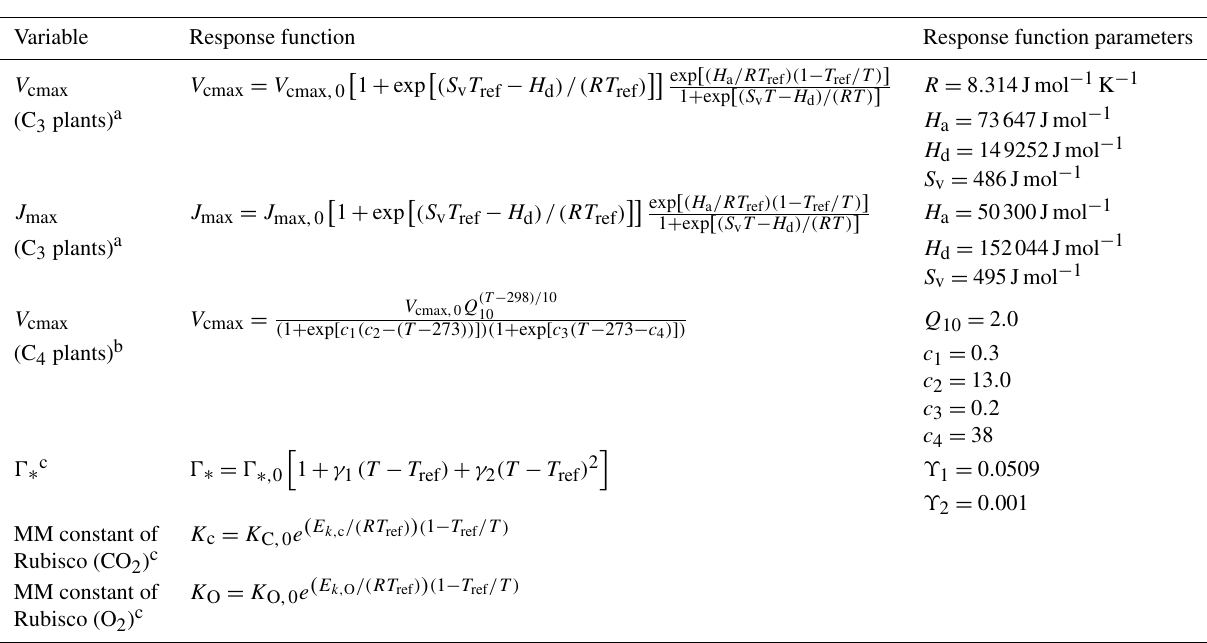
Table A3. Temperature response functions for